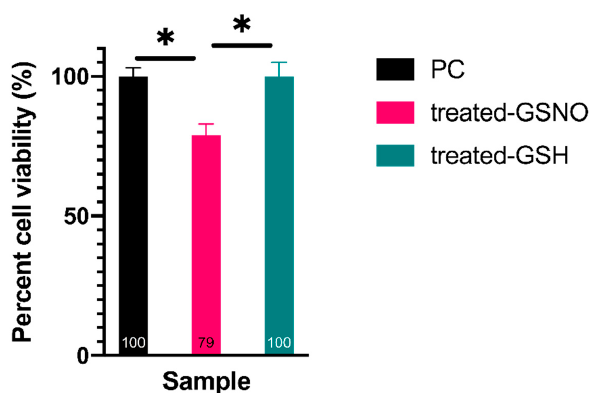
Figure 2. Percent cell viability of N2a neuroblastoma cells when exposed to 1 mM GSNO for 24 h at 37 ° C, 5% CO 2 assessed by the resazurin assay. Data points represent the mean of n ≥ 32 data points ± standard deviation. Treated-GSNO cells were determined to be statistically di ff erent than the positive control (PC) and the treated-GSH samples while the PC and treated-GSH samples were not statistically di ff erent at a 99% confidence interval (CI). Statistical significance at the 99% CI was illustrated graphically using * (1